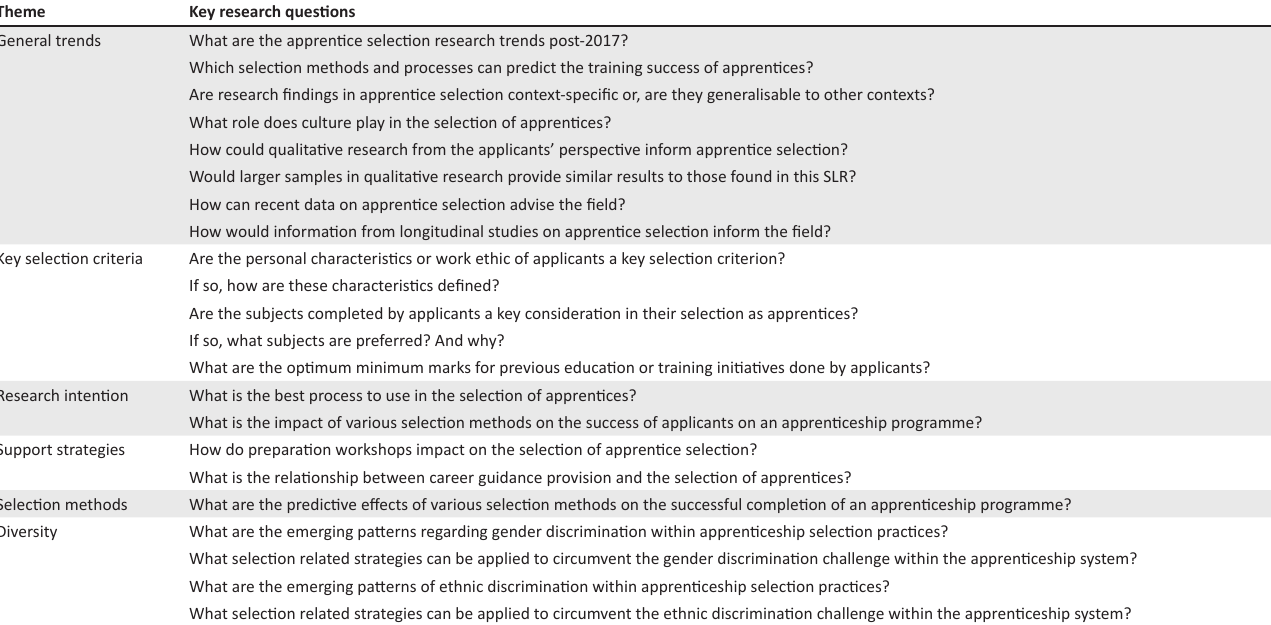
TABLE 7: A research agenda for apprentice